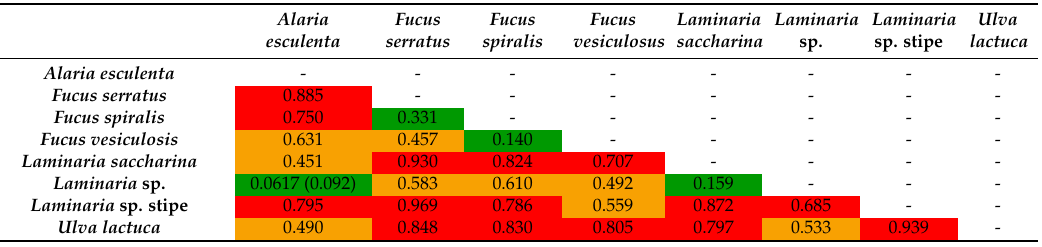
Table 3. ANOSIM group pairwise R values. All p -values < 0.001. All permutation values = 999. Red cells highlight R > 0.66, amber cells highlight 0.67 > R > 0.33, green cells highlight 0.34 > R. All p -values ≤ 0.001 unless otherwise stated in